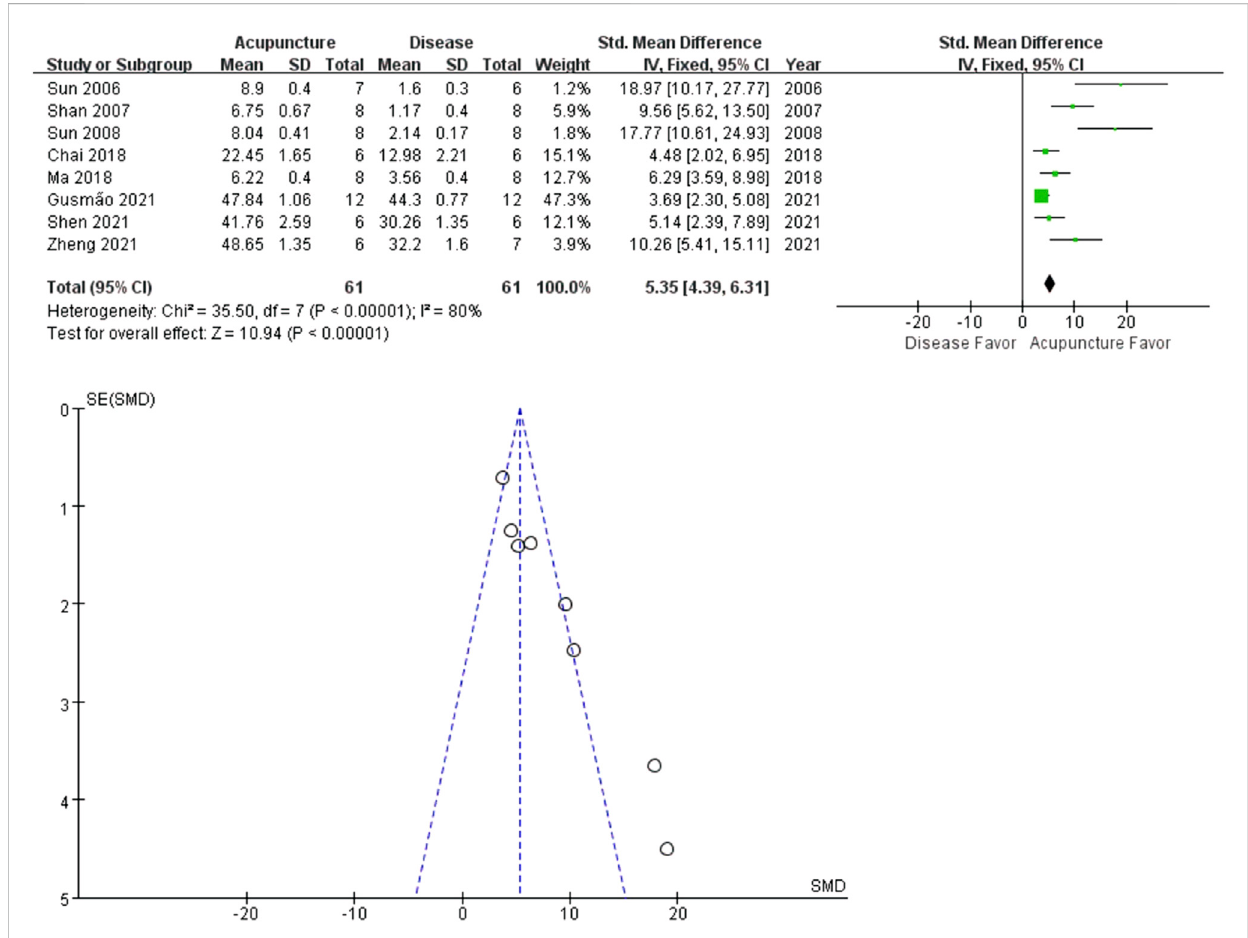
FIGURE 4 Meta-analysis comparing PWTs between the disease group and the acupuncture-treated